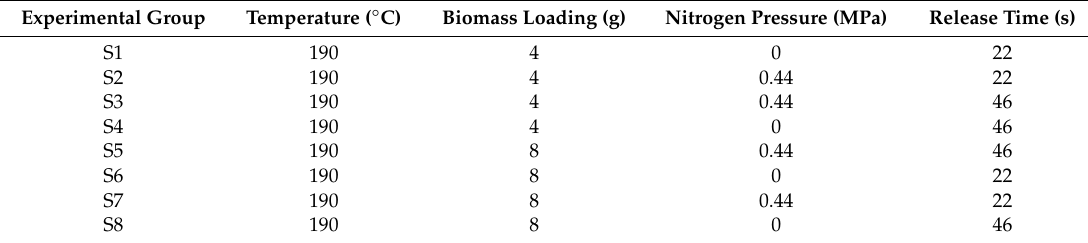
Table 2. Steam explosion experiment design.